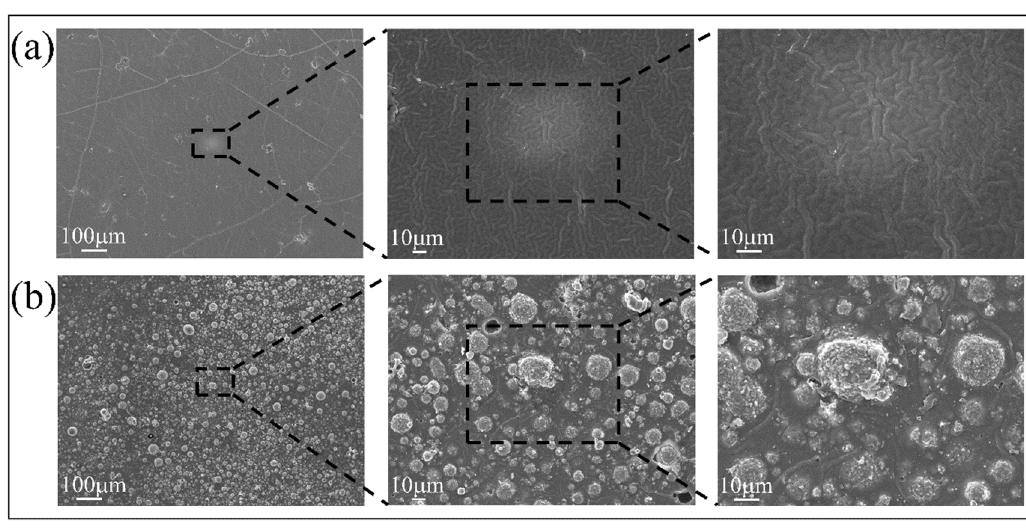
Figure 2. SEM images of ( a ) untreated polyethylene and ( b ) Si 3 N 4 -coated PE substrate at different magnifications.